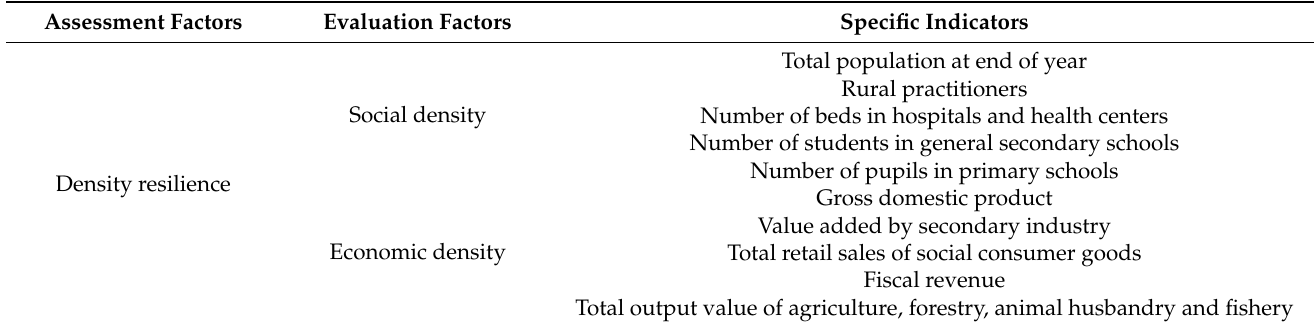
Table 3. Evaluation index system of urban